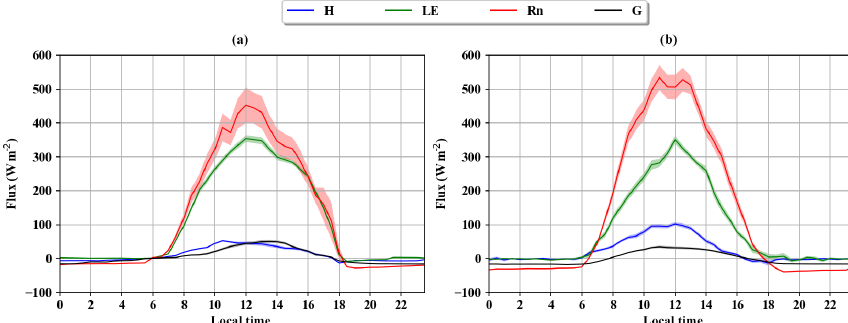
Figure 3. Average daily cycle of the radiation balance ( R n ) (Wm − 2 ), sensible heat flux ( H ) (Wm − 2 ), latent heat flux ( LE ) (Wm − 2 ) and